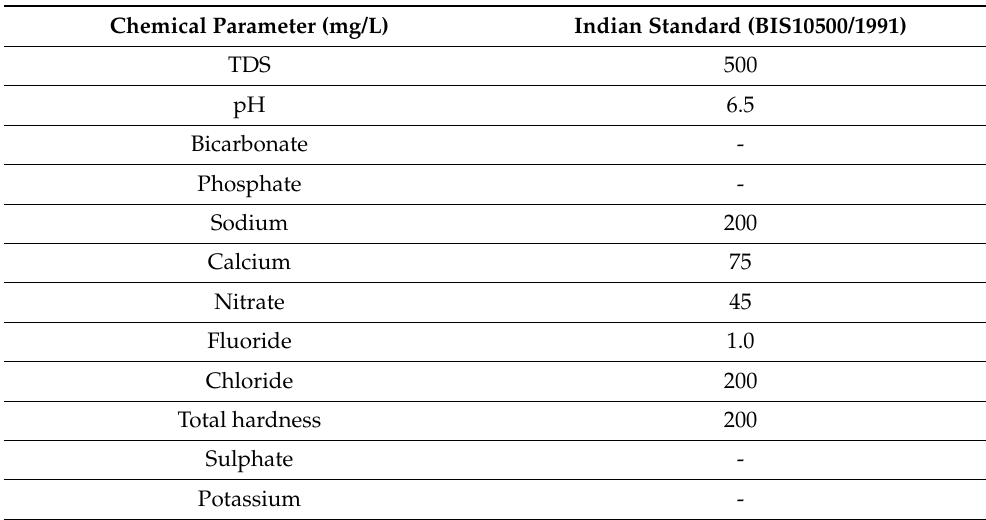
Table 1. Indian BIS standards for drinking water quality; all variables are in (mg/L) except pH (unitless) (Source—Indian Standard